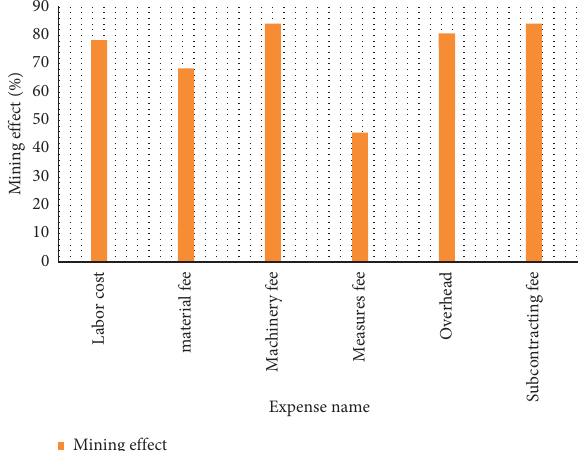
Figure 10: Statistical diagram of the effect of project cost